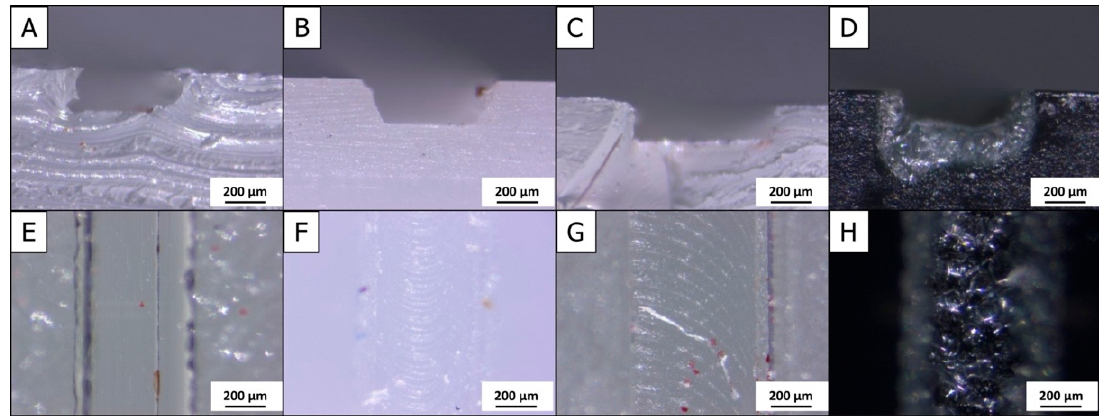
Figure 3. Microscopic pictures of cross ‐ section profiles and surface appearances of microchannels as prepared with the tools of a 3 ‐ in ‐ 1 3D printer device. Cross ‐ sections ( A – D ) and surfaces ( E – H ) are of ( A )/( E ) a 3D FDM ‐ , ( B )/( F ) a D ‐ CNC ‐ , ( C )/( G ) a M ‐ CNC ‐ , and ( D )/( H ) a laser ‐ fabricated microchannel.